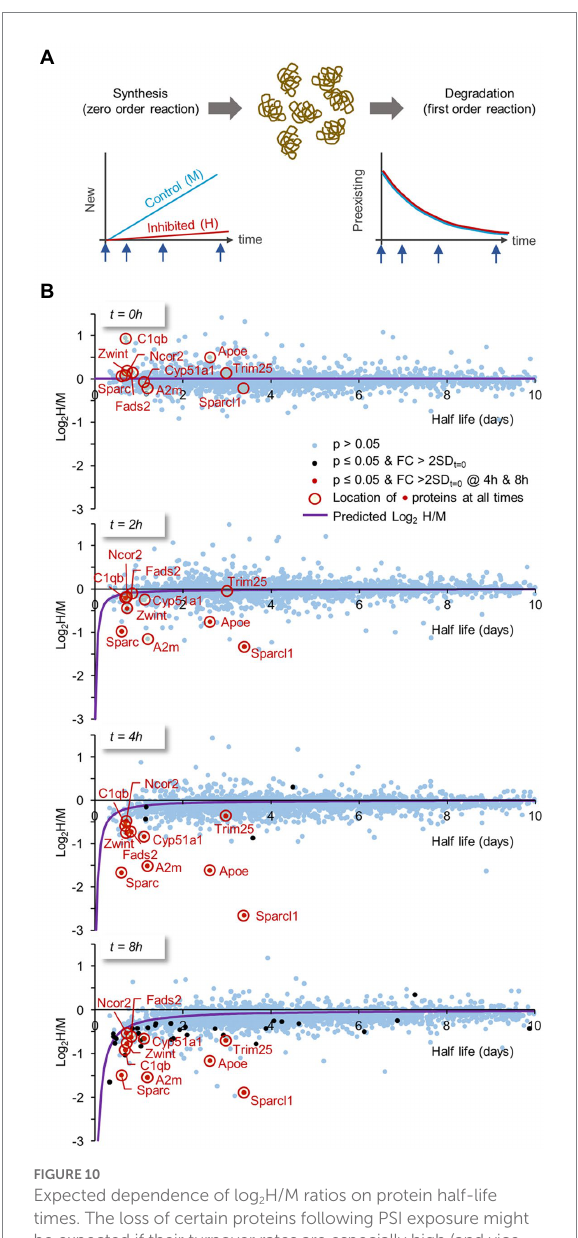
FIGURE 10 Expected dependence of log 2 H/M ratios on protein half-life times. The loss of certain proteins following PSI exposure might be expected if their turnover rates are especially high (and vice versa). Thus, we formulated a model describing the expected dependence of log 2 H/M on protein half-life times, which